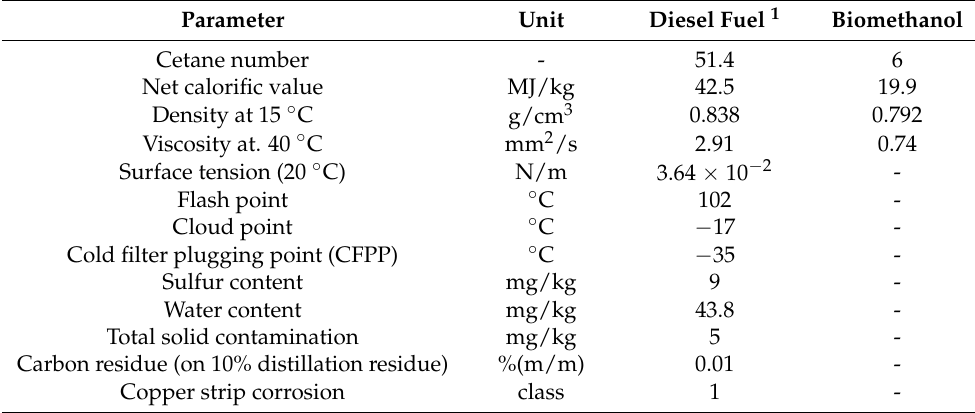
Table 2. Elementary physicochemical parameters of engine fuels used in the research. Parameter